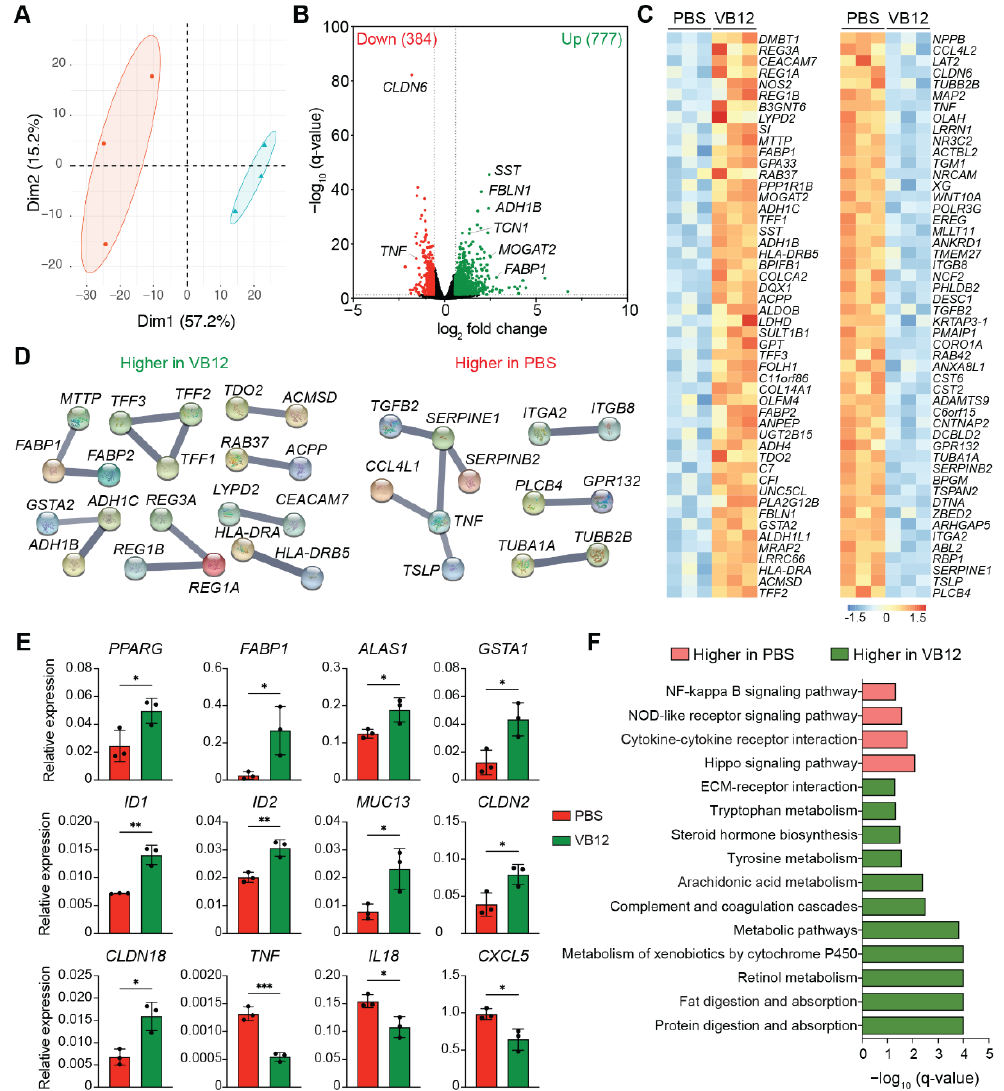
Figure 1. VB12-dependent regulation of transcriptomic responses in human iECs. The organotypic 3D human small intestine microtissues were cultured in the presence of VB12 or PBS (n = 3 sam- ples/group) using cells obtained from the ileal region of a 19-year-old female donor. Two weeks later, cells were collected for RNA-seq analysis. ( A ) PCA plot of transcriptomes of human iECs cultured in the presence of VB12 versus PBS. ( B ) Volcano plot of differentially expressed genes (DEGs; FDR < 0.05, fold change > 1.5) between VB12 and PBS groups. The number of upregulated (green) and downregulated (red) DEGs in the VB12 group is shown in parentheses. ( C ) Heat map showing top-50 DEGs. ( D ) STRING analysis depicting the networks of the top-50 DEGs. ( E ) qPCR validation of representative DEGs. ( F ) KEGG pathways of DEGs enriched in the VB12 versus PBS group. Bar graphs show mean ± SD. * p < 0.05, ** p < 0.01, *** p < 0.001; two-tailed unpaired t -test ( E ).